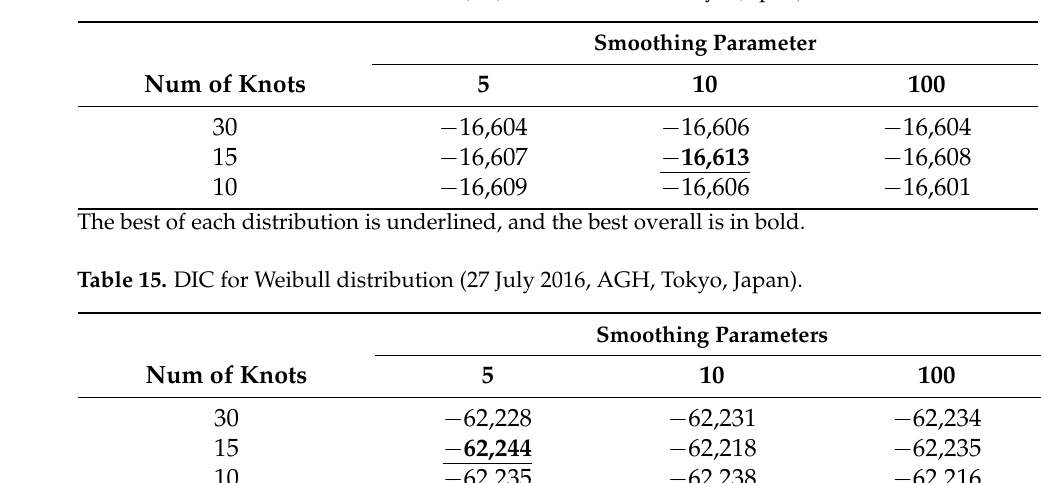
Smoothing Parameter